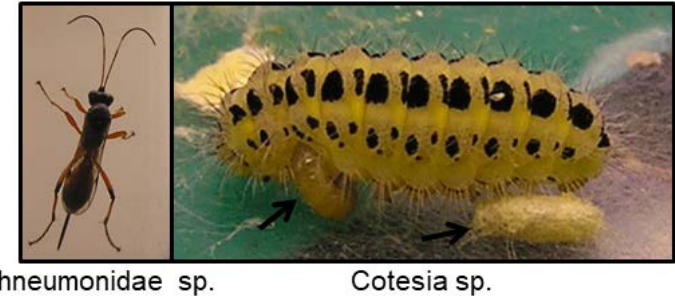
Figure 16. Ichneumonidae sp. emerged from a Z. filipendulae pupa and Cotesia sp. (arrows) infesting a Z. filipendulae larva (photos by Mika Zagrobelny).